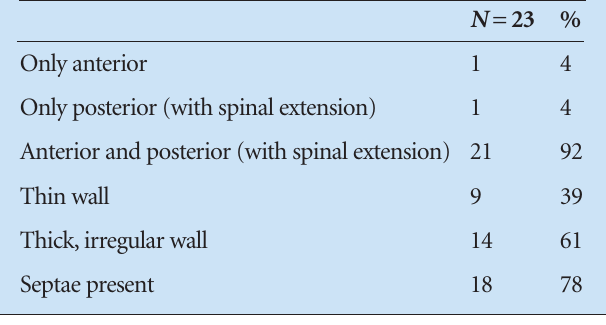
Table VI. Paravetebral abscess formation